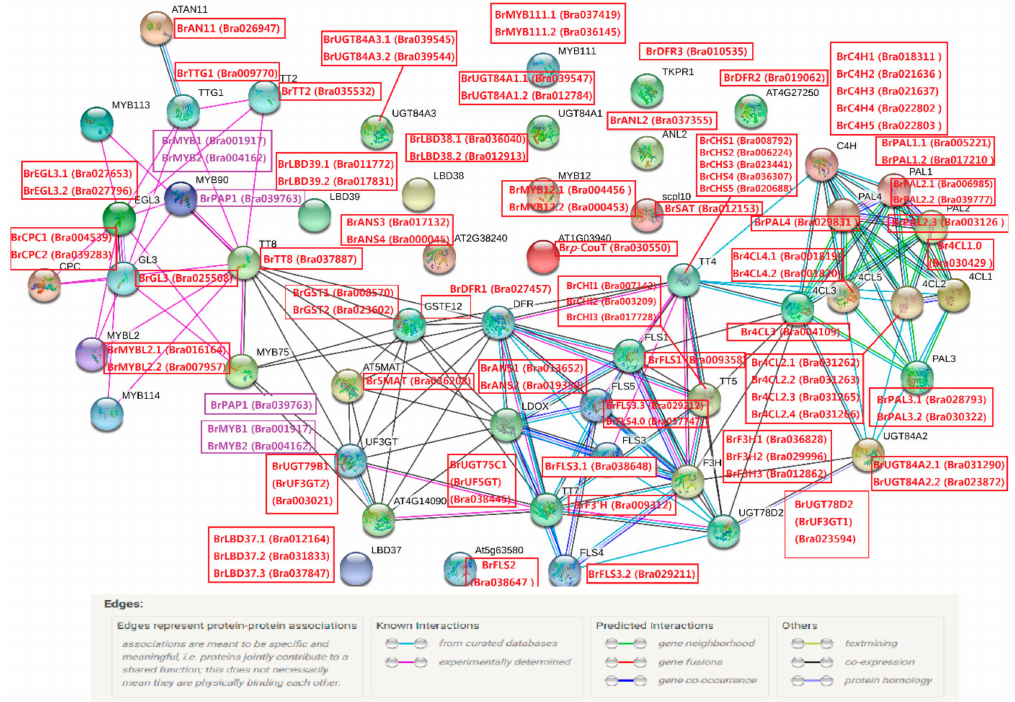
Figure 8. The putative interaction networks of anthocyanin biosynthesis genes in purple head Chinese cabbage. The homologous genes from Chinese cabbage and Arabidopsis are in red and black, respectively. Three R2R3-MYB TFs ‘BrMYB1’, ‘BrMYB2’, and ‘BrPAP1’ are highly homologous to MYB90 (AtPAP2, AT1G66390) and MYB75 (AtPAP1,